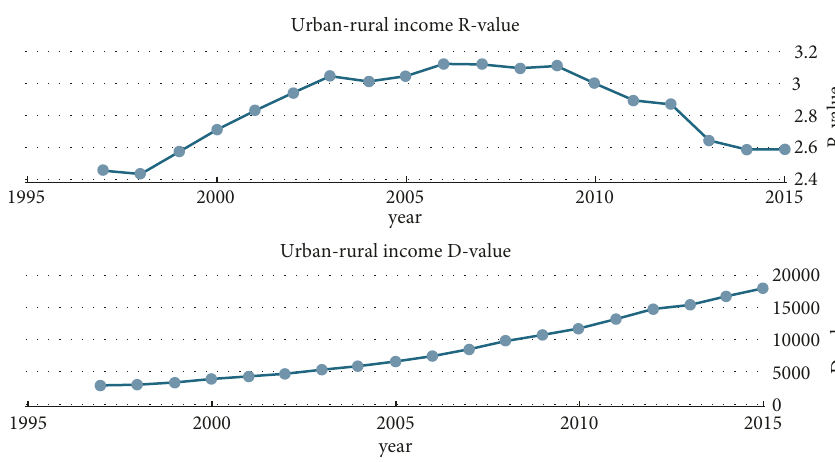
Figure 2: Urban-rural income inequality from 1997 to 2015 in